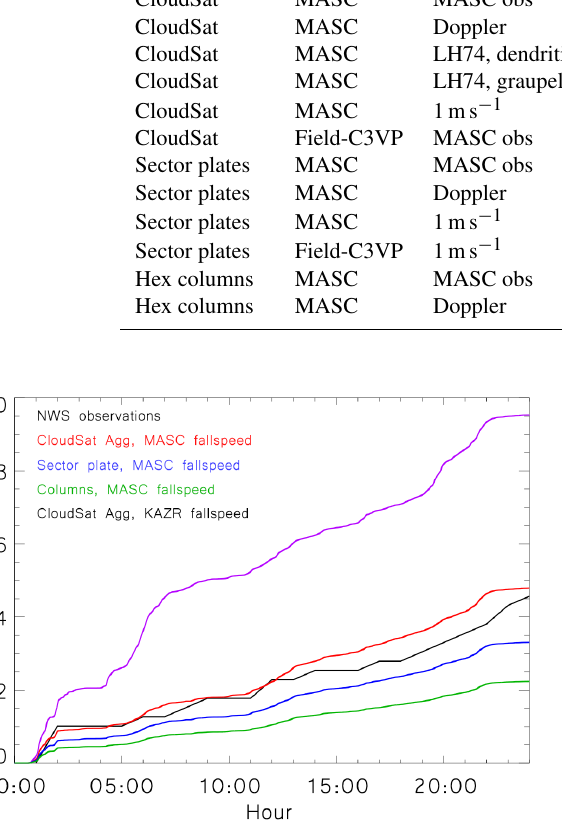
Figure 7. Hourly NWS snowfall accumulations (mm) plotted against retrieved values for the 23 April event for different retrieval assumption permutations. MASC PSD slope parameter ( λ ) is as- sumed for all curves.